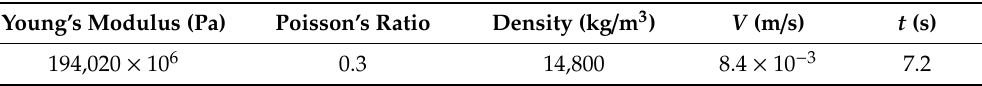
Table 2. The parameters of the needle during the simulation and